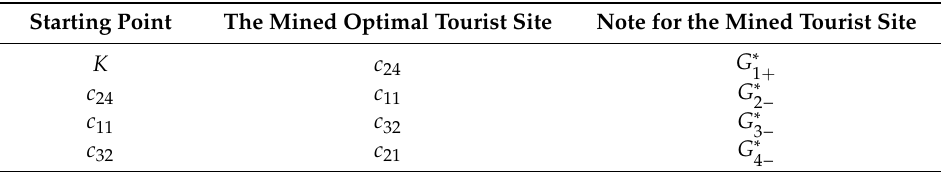
Table 8. The searching process for optimal tourist